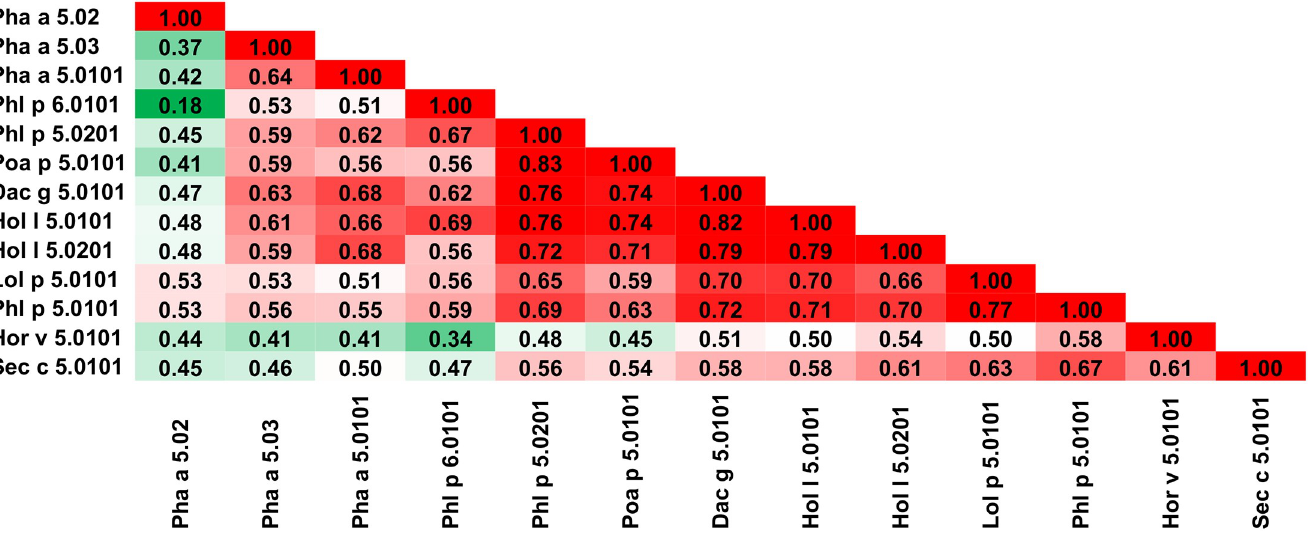
Fig 17. Plot showing A-RISC index values for allergen pairs from Group V/VI grass pollen allergens. Red color indicates a high risk of cross-reactivity, a dark green color indicates a low risk of cross-reactivity, and intermediate colors correspond to a medium risk of cross-reactivity.